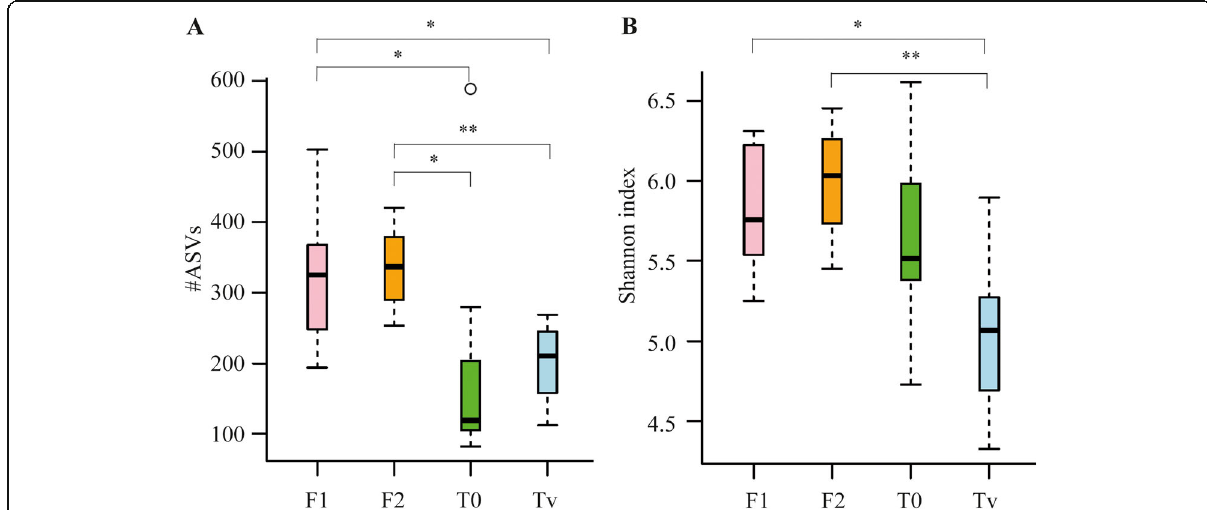
Fig. 1 Bacterial α -diversity metrics ( A : Amplicon Single Variants (ASV) richness, and B : Shannon index) of the gut of rainbow trout submitted to four different diets ( n = 9 fish/diet). T 0 : commercial fishmeal-rich diet; Tv: full terrestrial plant-based diet devoid of fishmeal; F1: plant-based diet in which 11% of plant proteins have been replaced by 5.5% of proteins from yeast (YEA) and 5.5% of proteins from insect larvae (INS); F2: plant- based diet in which 16.5% of plant proteins have been replaced by 5.5% YEA, 5.5% INS and 5.5% processed animal proteins (PAP). The kruskal- wallis pairwise test was used to perform the statistical comparisons among diets. Significance: *, p -value < 0.05; **, p -value < 0.01; ***, p -value < 0.001